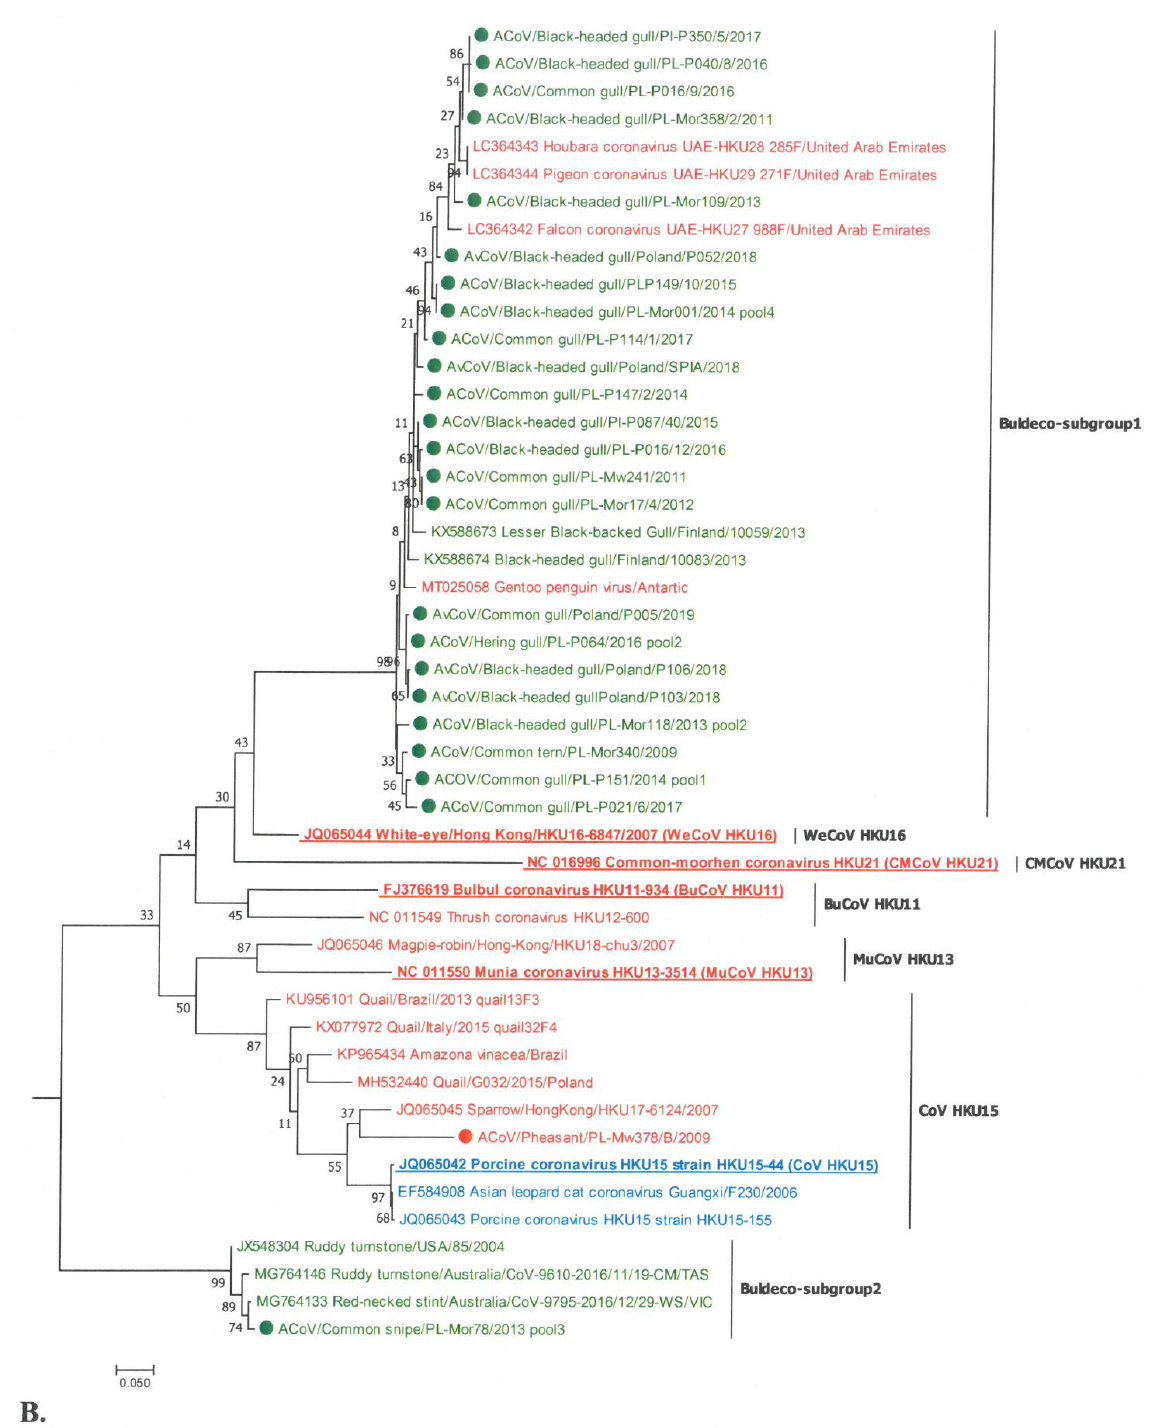
Figure 2. Phylogenetic analysis of deltacoronaviruses based on the replicase gene fragment. ( A ) The tree constructed for 58 deltacoronaviruses: 26 strains identified in wild birds in Poland (marked with a dot) and 32 from GenBank, including seven reference strains (written in bold and underlined) representing ratified species of three subgenera (five of Buldecovirus , and one for Ardecovirus and Herdecovirus ) of the Deltacoronavirus genus. ( B ) Deltacoronaviruses of the Brangacovirus subgenus. Colored font for given bird orders: black indicates Anseriformes , indicates Charadriiformes, red indicates other bird orders, and blue indicates mammal species. The tree was constructed using MEGA 7 using the maximum likelihood method based on the GTR + G model and 1000 bootstrap replicates (bootstrap values shown on the tree).